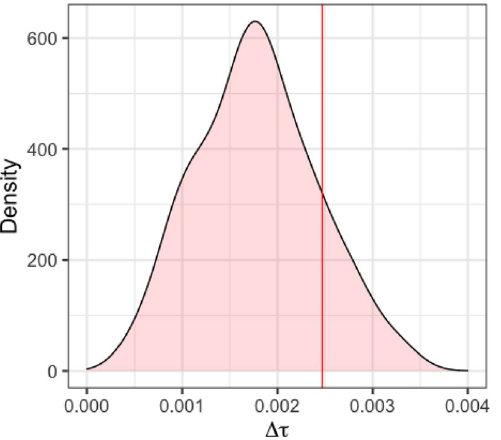
Figure 3. The difference in the personal technical fouls call rate between same and different referee-player race is not statistically different than the one expected by random